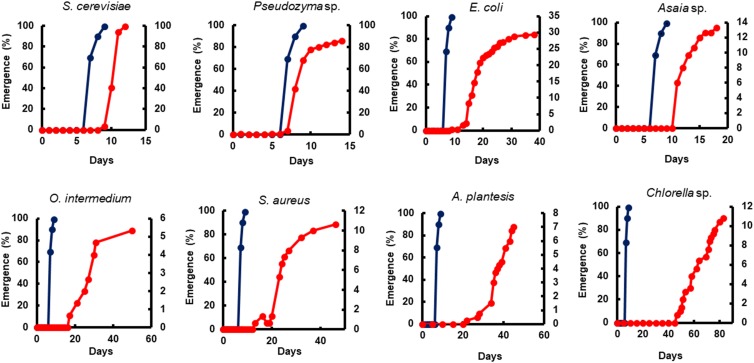
The impact of microorganism-based diets on adult emergence. A representative emergence curve is comparing larvae fed with Tetramin (Dark blue line, left y-axis) and larvae fed with microbial cells (red line, right y-axis). The dietary supply was administered only at L1. Dead individuals were removed daily.